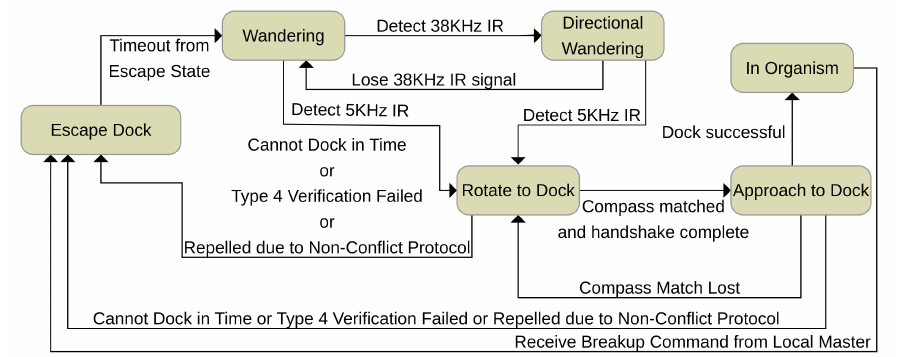
Figure 2. A finite state machine for the self-assembly controller. Robots start by default in the wandering